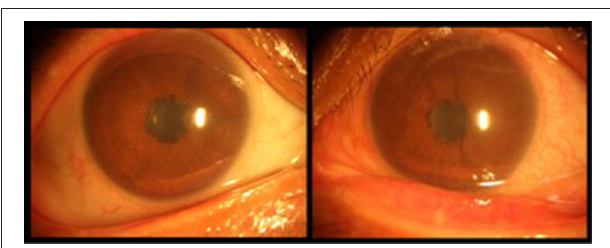
FIGURE 1 | Typical anterior segment photograph of iridocyclitis. best-corrected visual acuity-left and best-corrected visual acuity- right ( P < 0.001) between the two groups. More participants’ demographic data are presented in Table 1 .